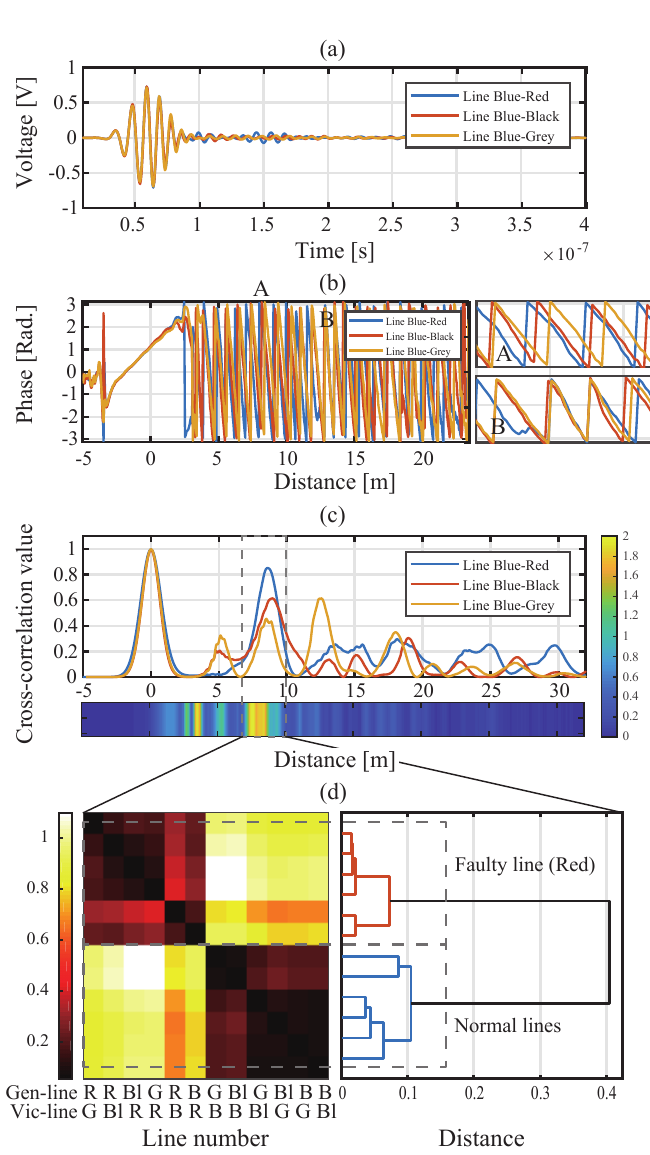
Figure 6. Fault detection and classification results with the blue line as the generator line. ( a ) TFDR reflected signals, ( b ) phase estimation results, ( c ) TFCC and ANN results and ( d ) heat-map representation and hierarchy clustering results on TFDR